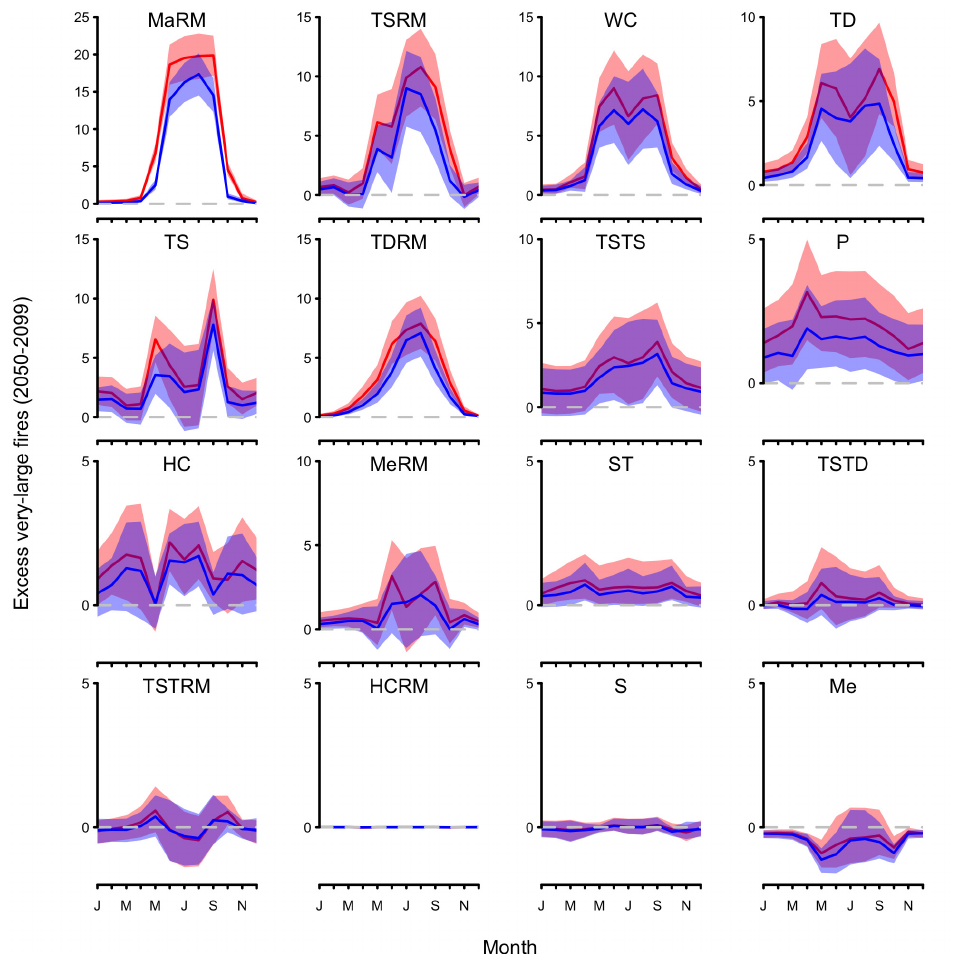
Figure 5. Predicted intra-annual changes in very-large fire frequency across sixteen biogeographical regions within the Continental United States under the RCP 4.5 (blue) and RCP 8.5 (red). The central 90th percentile and mean of the excess very-large fires are based on 1,000,000 random samples of the posterior multi-model average very-large fire probabilities from the historical (1956–2005) and future (2050–2099)